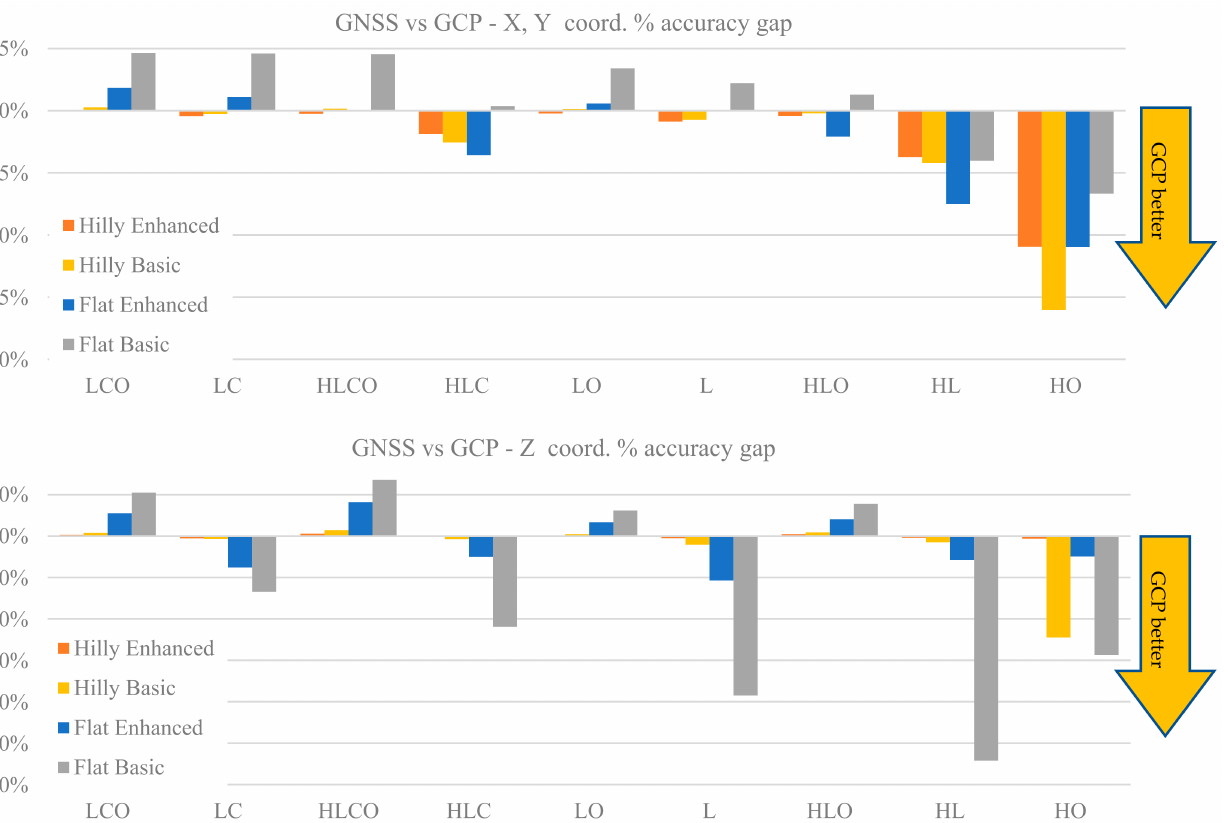
Figure 9. Percentage accuracy gap between the GCP and the GNSS cases, relative to the GCP case, for tie point coordinates’ RMSE as a function of the nine configurations, of the terrain type (Flat, Hilly) and of the control tightness (Basic or Enhanced). Positive values mark a better RMSE for GNSS compared to GCP, and vice versa for negative values. ( Top ): horizontal coordinates; ( bottom ):